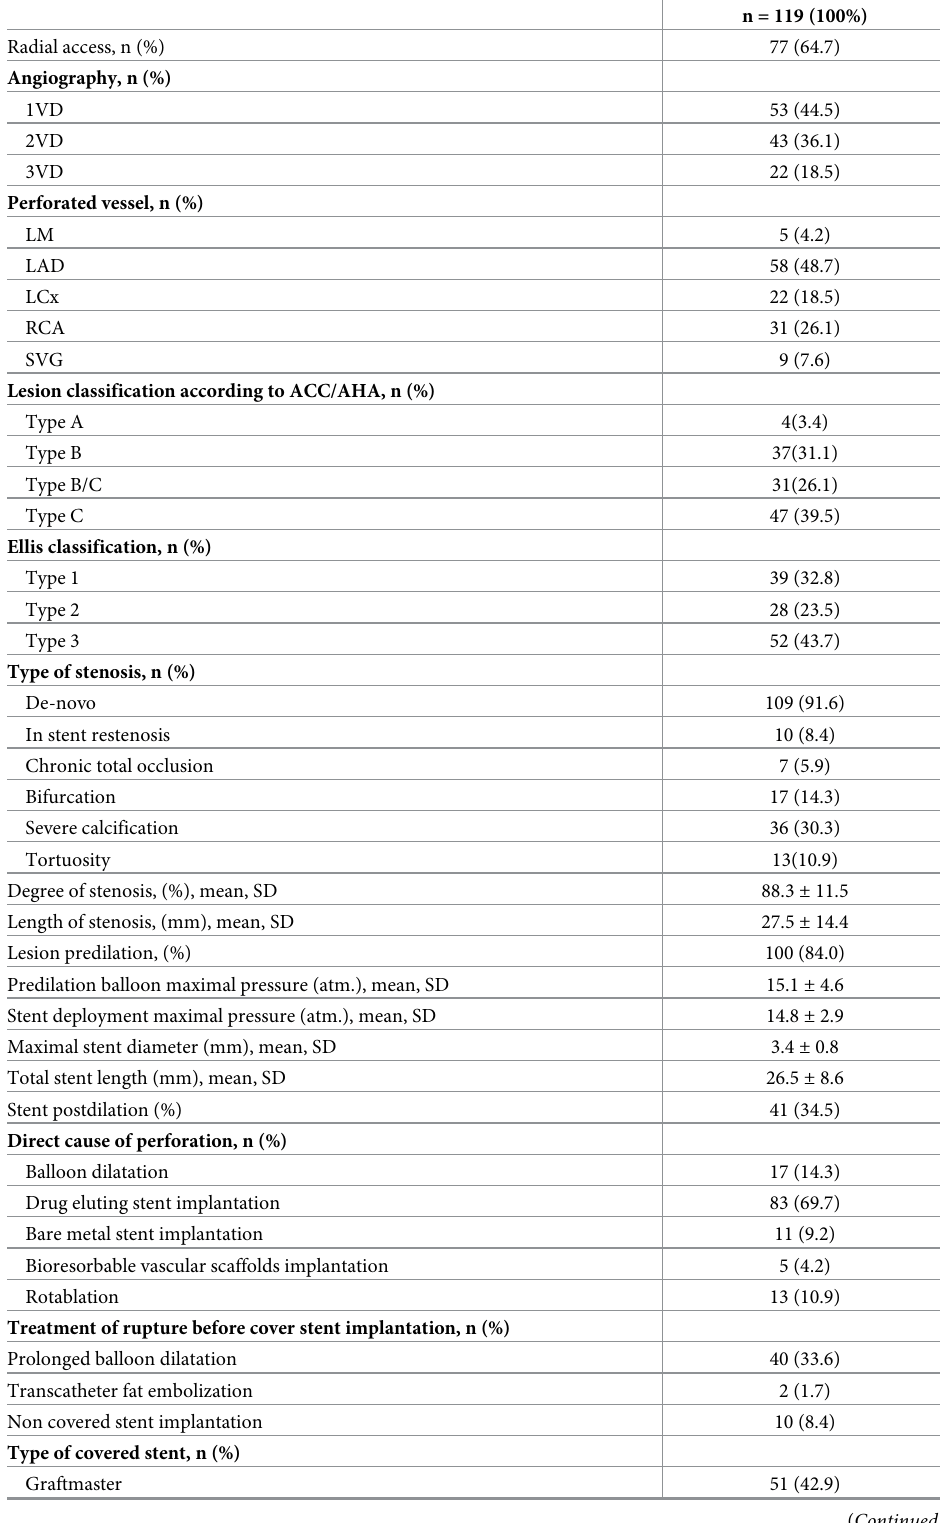
Table 2. Angiographic and procedural